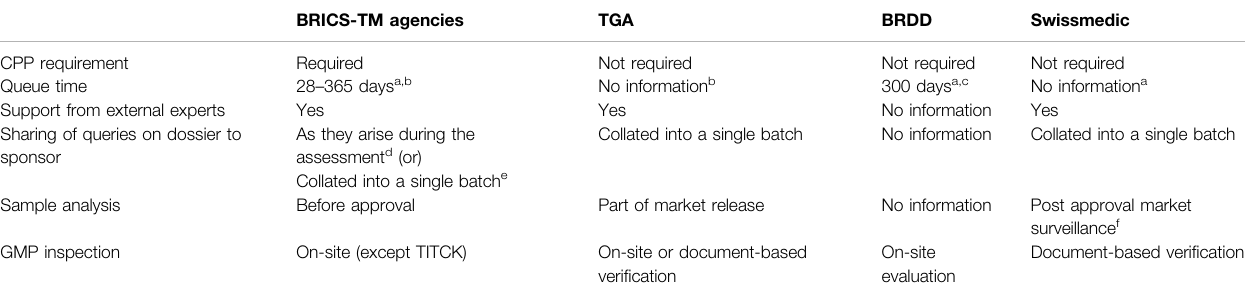
TABLE 3 | Comparison of dossier review and approval process in BRICS-TM with ACSS